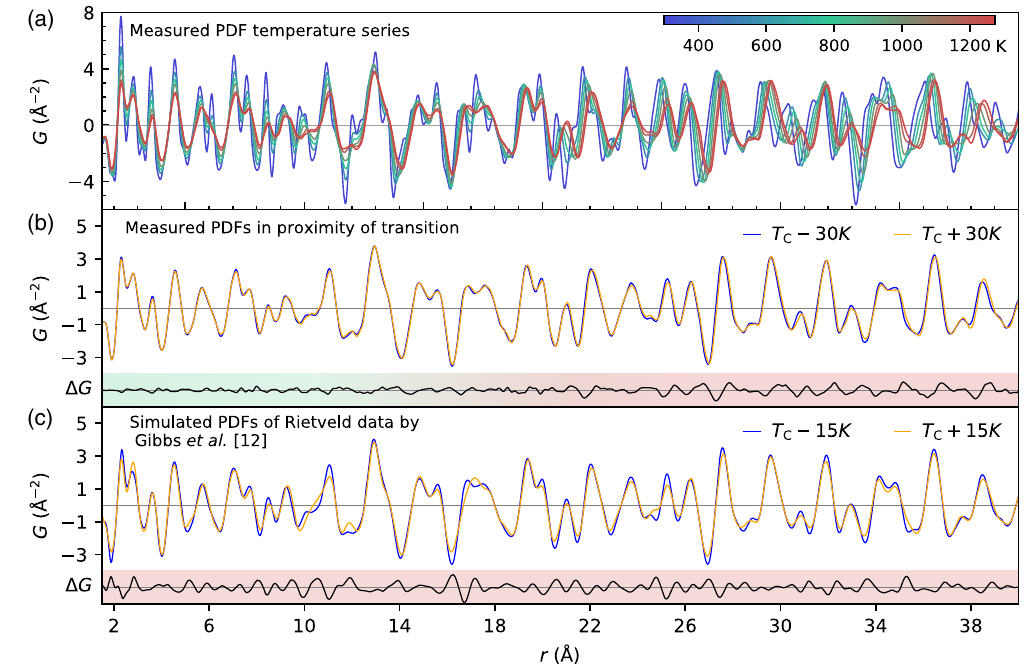
FIG. 3. (a) Experimental PDFs for 473 – 1273 K temperature interval in 100 K increments. The full set of PDF data on a denser ( Δ T ¼ 20 K) grid and further details are provided in Figs. S7 and S8 of the Supplemental Material [26]. The data temperature is color coded, as indicated by the horizontal color bar. Comparison of PDFs for temperatures bracing the structural transition temperature T shown in panels (b) and (c) as follows. Experimental PDFs from our measurements are displayed in panel (b). Simulated PDFs, calculated using the average structure information from Rietveld refined structures reported by Gibbs et al. [12] across the transition, are shown in panel (c). Corresponding difference curves are shown underneath. The shaded green and red areas behind the difference curve indicate, respectively, regions of low and high difference. The presence of length scales exhibiting different behavior can be readily evidenced by comparing the difference curves in panels (b) and (c). At low r , the measured PDFs change appreciably less than what would be expected if the average crystallographic picture were applicable to the local structure, as portrayed by the simulated PDFs. In contrast, the changes across the transition at high r are of similar amplitude in both panels. Note that the structural phase transition temperature in Ref. [12] is 1258 K, 35 K higher than in our measurements. Comparison of simulated PDFs based on structural parameters from the Rietveld refinements of Gibbs et al. to that of this work is provided in Fig. S9 of the Supplemental Material